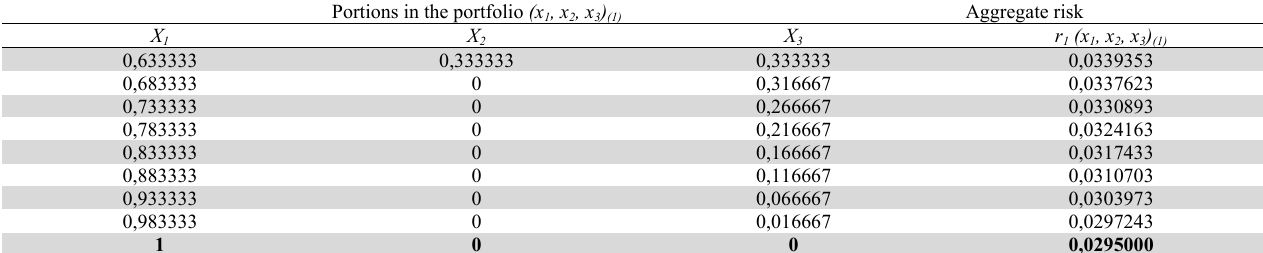
Fragment of the decision table in forming the optimal structure of the investment program (strategy 3) Portions in the portfolio (x 1 , x 2 , х 3 )